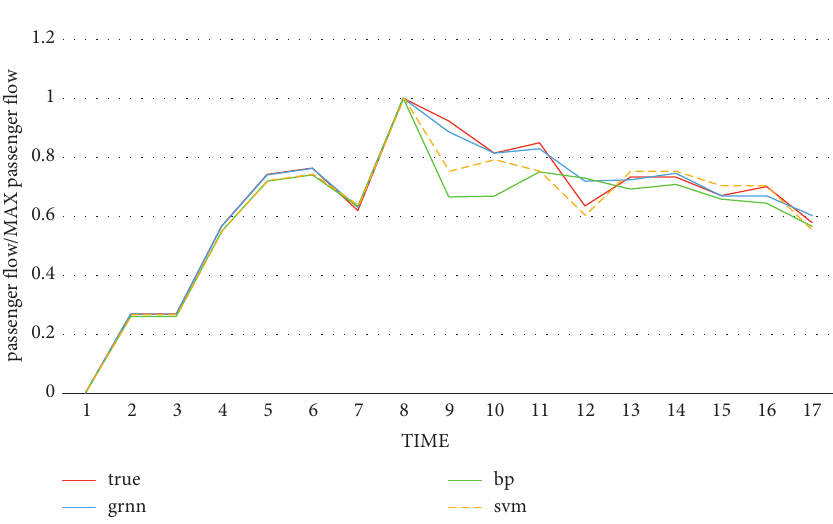
Figure 7: Test comparison of different prediction methods (July 1). Table 5: Validation prediction and evaluation